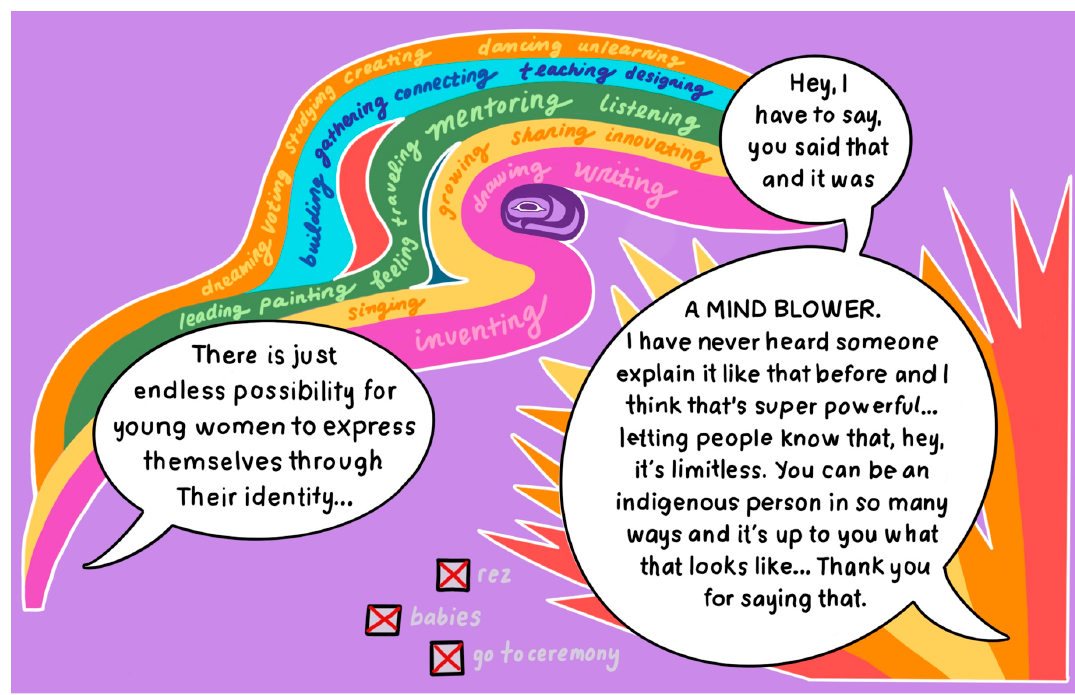
Figure 14. In this panel a rainbow of ways of expressing indigeneity flow from one unseen speaker to another. See I.D. 14 in Appendix A.